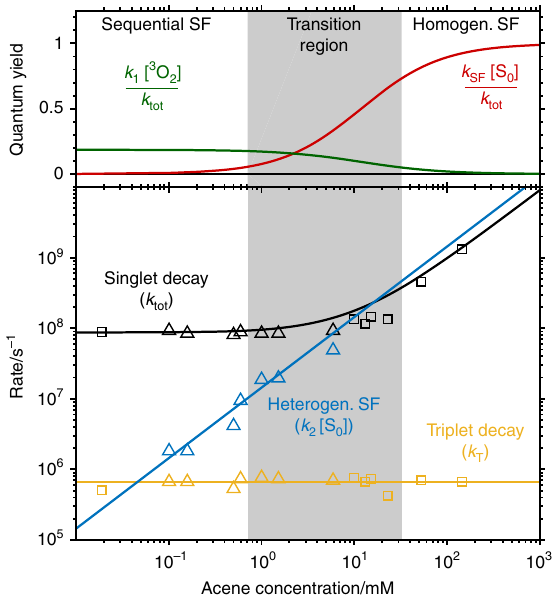
Fig. 5 Singlet fi ssion (SF) quantum yields and rate constants obtained by a global fi t. The upper panel shows the acene concentration dependence of the SF quantum yield. The lower panel analyses the concentration dependence of the three rate constants explaining the time evolution of the singlet and triplet concentration. The experimental results perfectly reproduce the trend expected for the model of catalysed SF. For c ≤ 1 mM, k 7 /s, whereas R has a concentration-independent value of (8.57 ± 0.19) × 10 for c ≥ 10 mM, a linear fi t of k tot (black) yields a slope of (8.98 ± 0.36) × 10 9 /Ms, which is attributed to k SF . As expected from the model (Fig. 4), an intermediate component — attributed to heterogeneous singlet fi ssion — can be observed only in a concentration range of 0.1 mM < c < 10 mM. The slope of the linear fi t provides a value of k 2 = (1.62 ± 0.19) × 10 10 /Ms. This value is in very good agreement with reported oxygen quenching rates 31